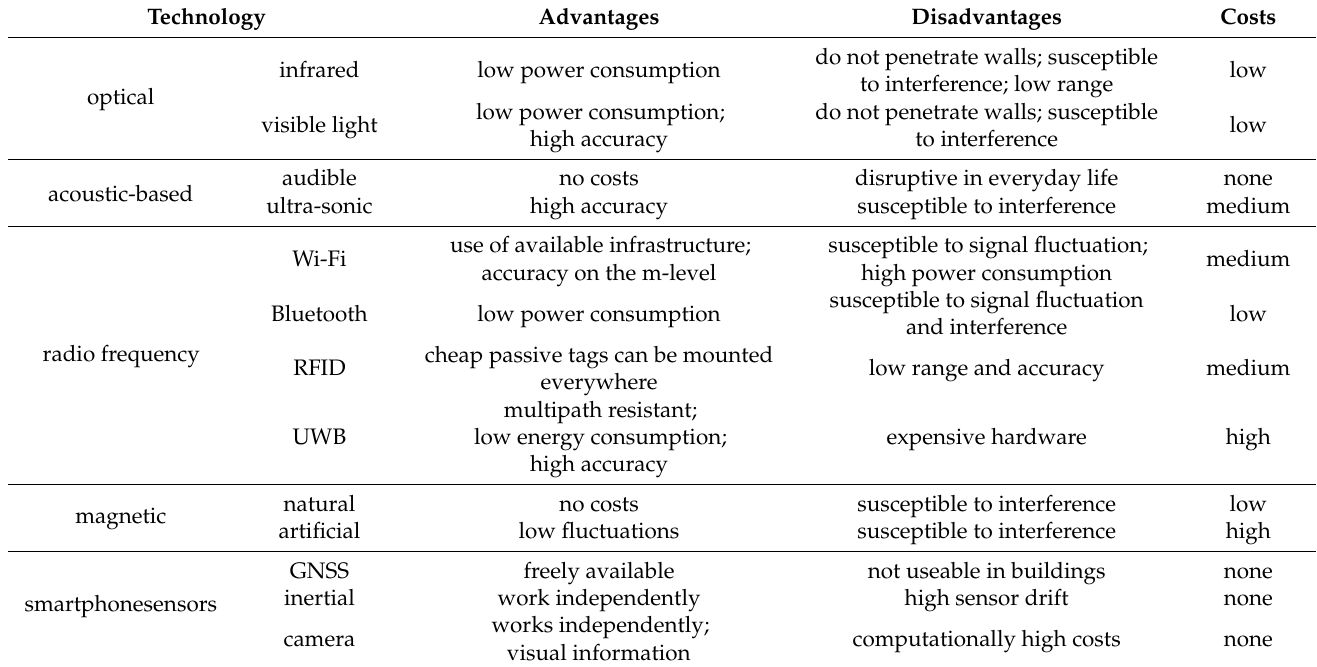
Table 1. Positioning technologies comparison.